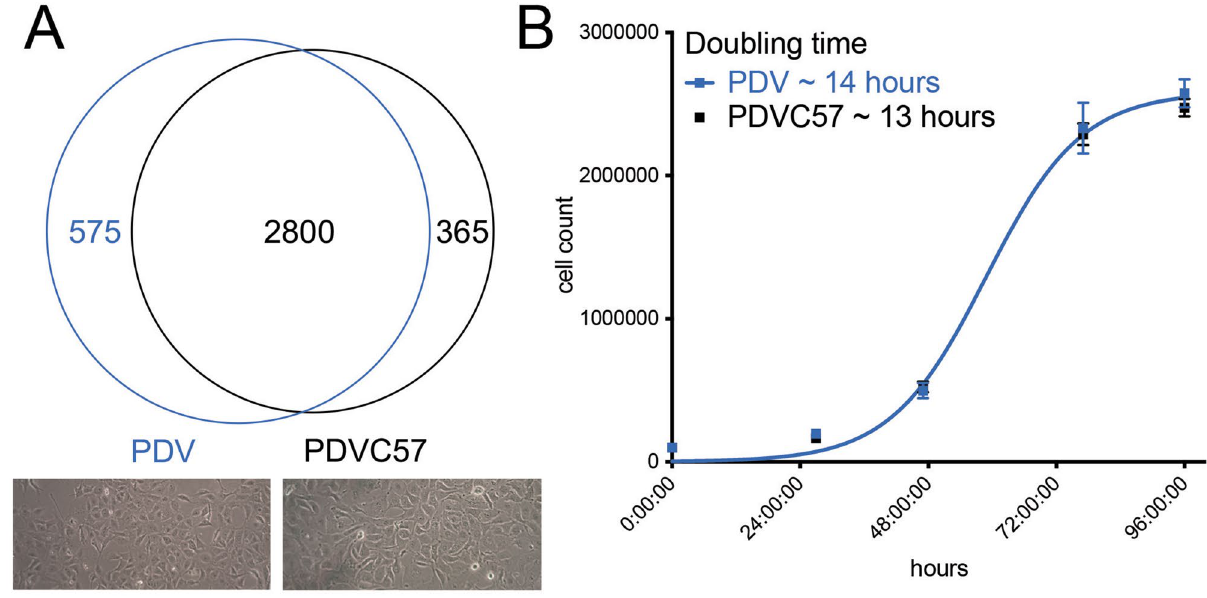
Figure 1. PDV and PDVC57 have similar exonic variants and doubling times in vitro. ( A ) Upper: whole exome sequencing revealed that the two cell lines shared 2800/3640 (76.9%) of exonic variants compared to normal mouse peripheral blood leukocytes; lower panels demonstrate light microscopy images of the cell lines growing in vitro, with PDVC57 (right) demonstrating greater size and granularity than PDV (left). ( B ) Logistic growth curves of the two cell lines that show no significant difference between the growth curves using the F-test, P =